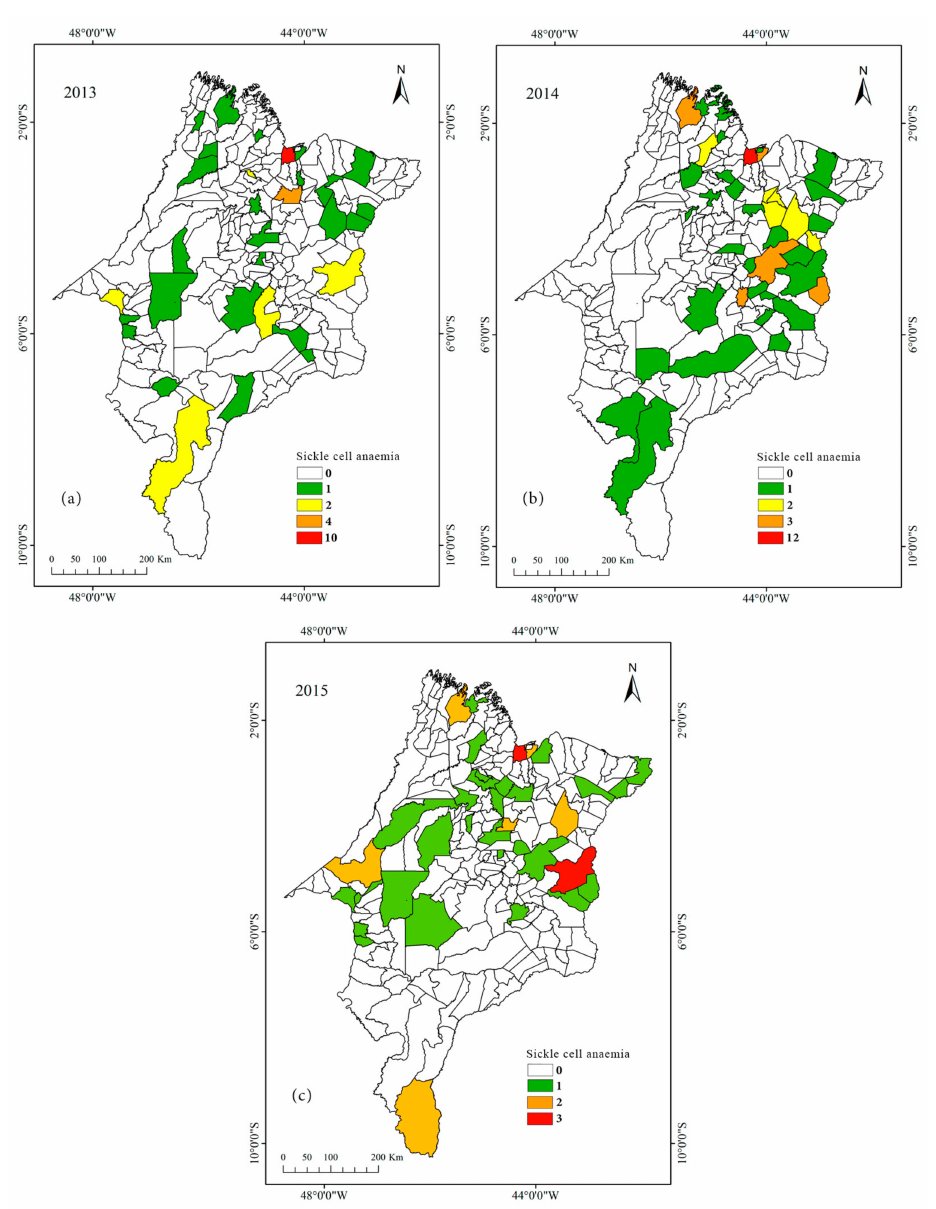
Figure 1. Spatiotemporal distribution of sickle cell anaemia cases in newborns in Maranh ã o in 2013 ( a ), 2014 ( b ), and 2015 ( c